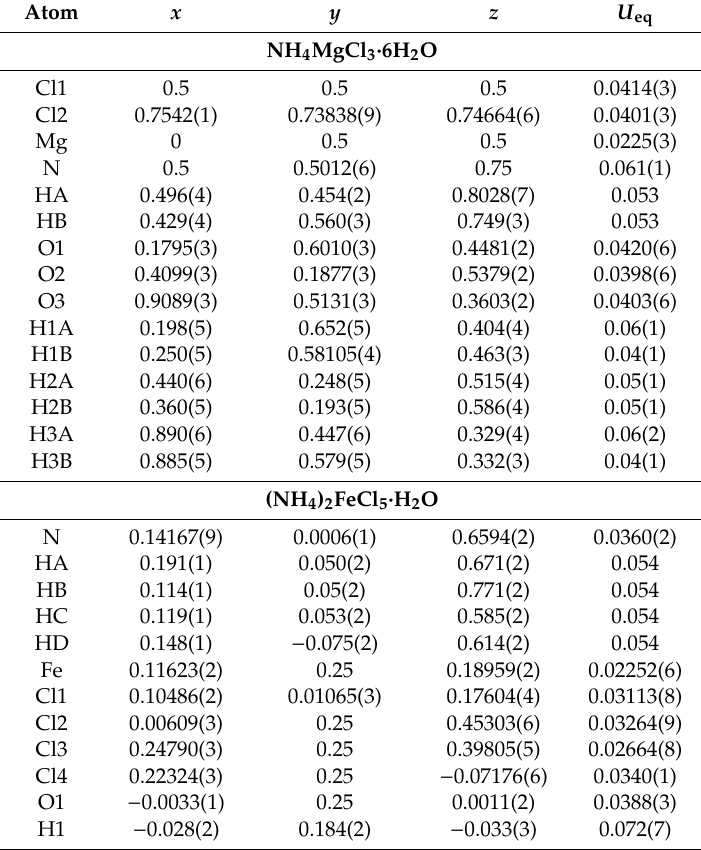
Table 5. Atomic coordinates and equivalent isotropic displacement parameters (Å 2 ). U eq is defined as 1 / 3 of the trace of the orthogonalised U IJ